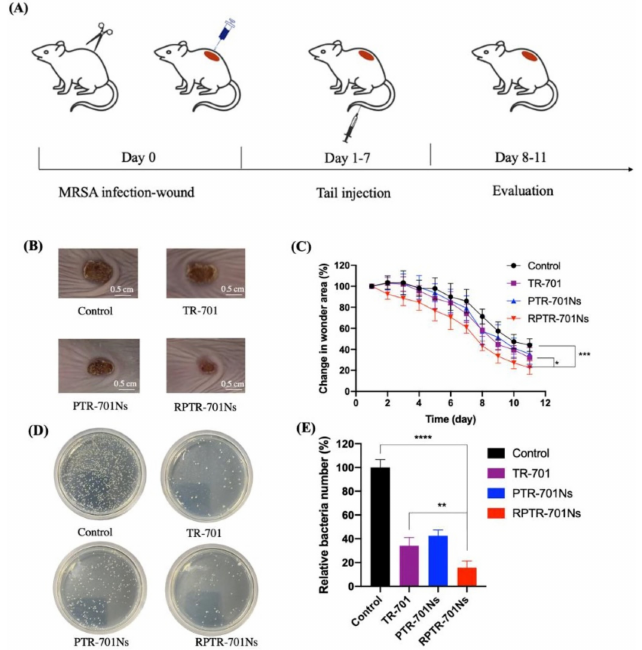
Figure 12. In vivo antibacterial effect of RPTR-701 NPs on MRSA-infected mice, ( A ) Schematic diagram of MRSA-infected model establishment and treatment plan, ( B ) Wound skin after treated with PBS, TR-701, PTR-701Ns and RPTR-701Ns, ( C ) Relative change in the wound area, ( D ) LB culture pates of different groups of skin, ( E ) Quantitative analysis of bacteria colony, Data were presented as mean * p < 0.1, ** p < 0.01, *** p < 0.001, **** p < 0.0001 [106]. Copyright 2021,